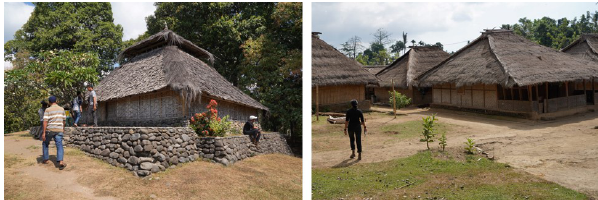
Fig. 6. Traditional Houses in Senaru Village, Bayan Dis- trict, North Lombok that Survived the Earthquake Source: Kompas, Danu Kusworo